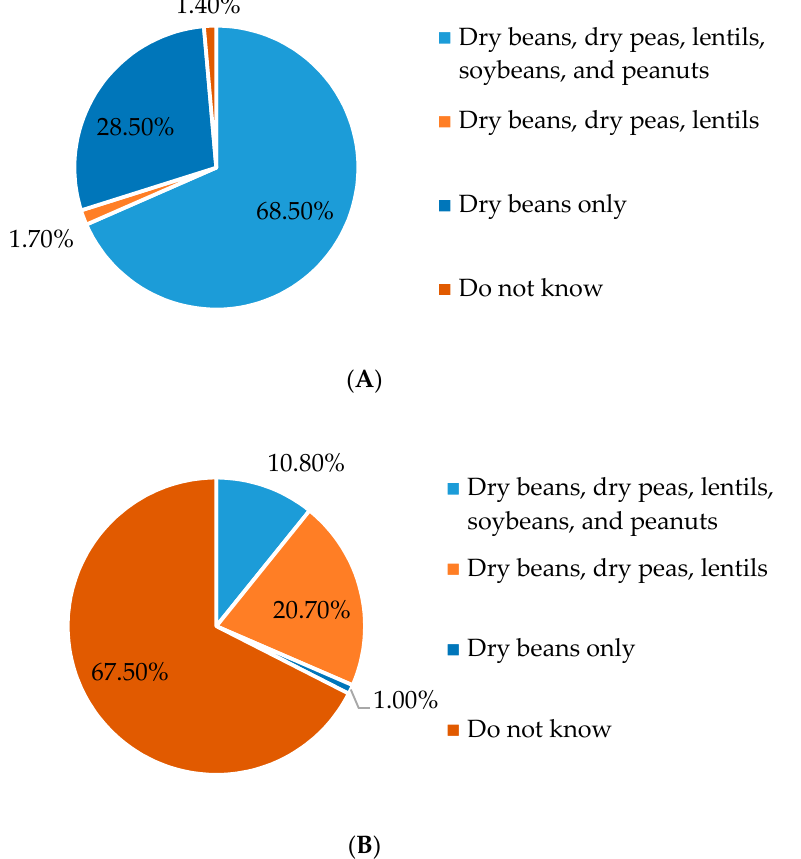
Figure 2. Response percentages for knowledge of the terms ( A ) ‘legumes’ and ( B ) ‘pulses’ by Arizona Registered Dietitians ( n = 296).